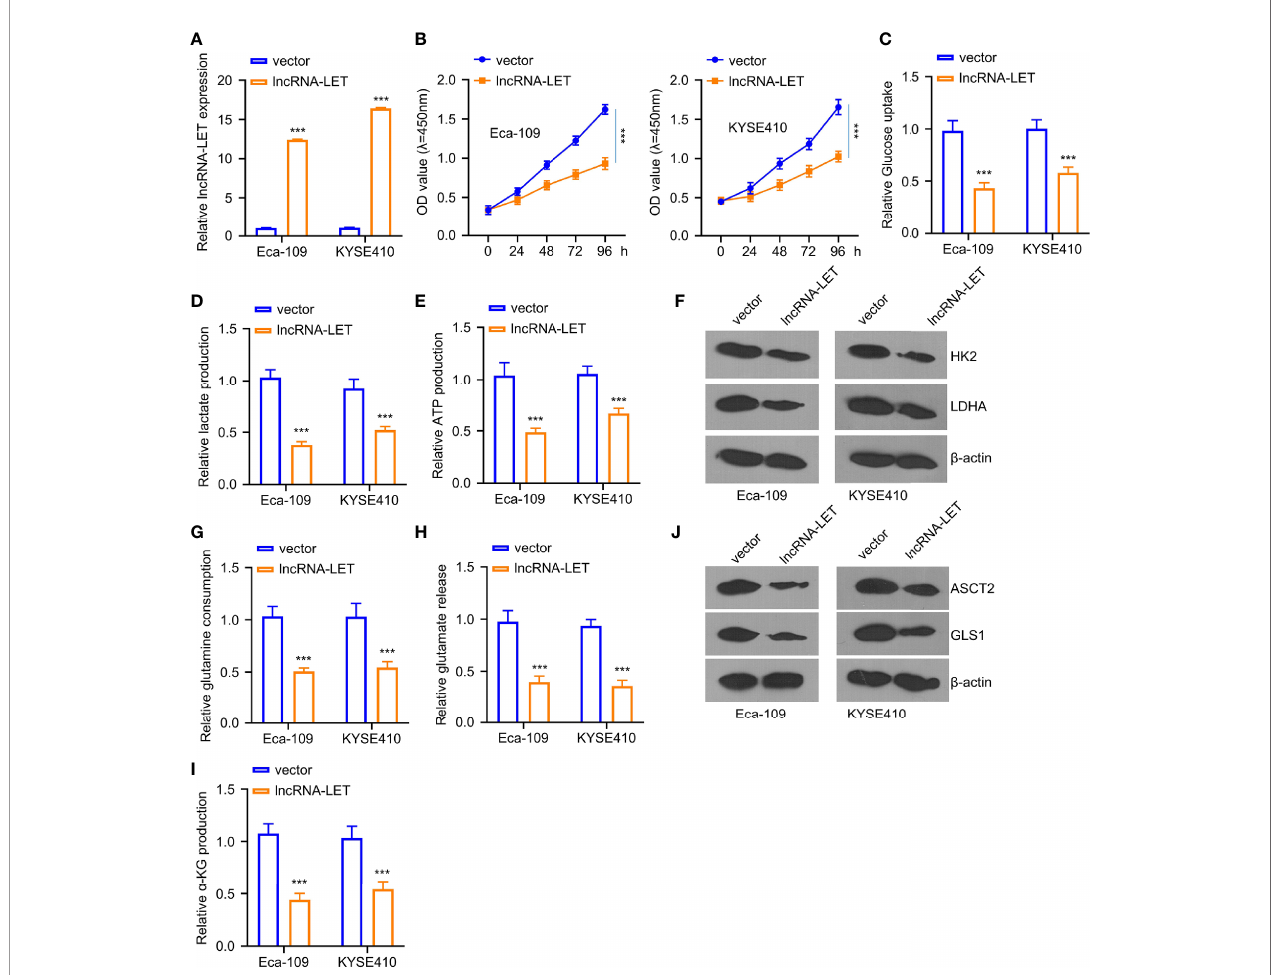
FIGURE 2 | (A) The transfection ef fi ciency of plasmid pcDNA lncRNA-LET was determined through qRT-PCR. (B) Cell viabilities in Eca-109 and KYSE410 cells transfected with or without lncRNA-LET pcDNA at 0, 24, 48, 72, and 96 h were measured through CCK-8 assay. (C – E) The levels of glucose, lactate, and ATP production were detected by the glycolysis kit. Western blotting was used to detect (F) the expressions of HK2 and ldhA proteins in Eca-109 and KYSE410 cells with or without lncRNA-LET transfection. (J) ASCT2 and gls1 protein levels in different groups (vector, lncRNA-LET). (G – I) The levels of glutamine, glutamic acid, and a -glutamine in cells after control vector or lncRNA-LET pcDNA transfection were detected by a -KG detection kit. *** P <